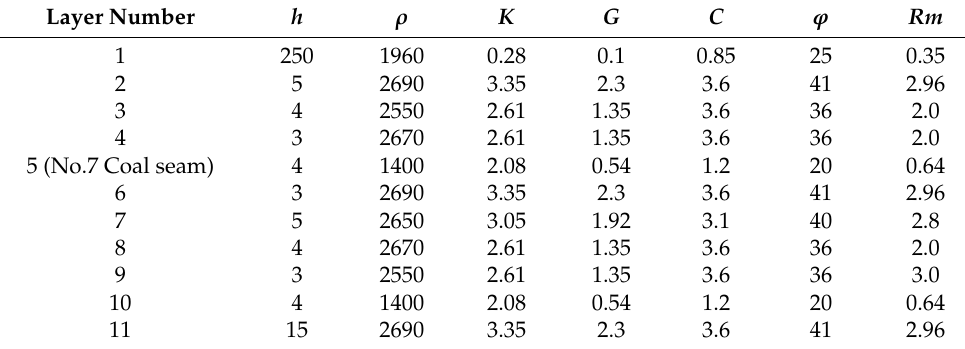
Table 1. Rock mechanics parameters for numerical models.